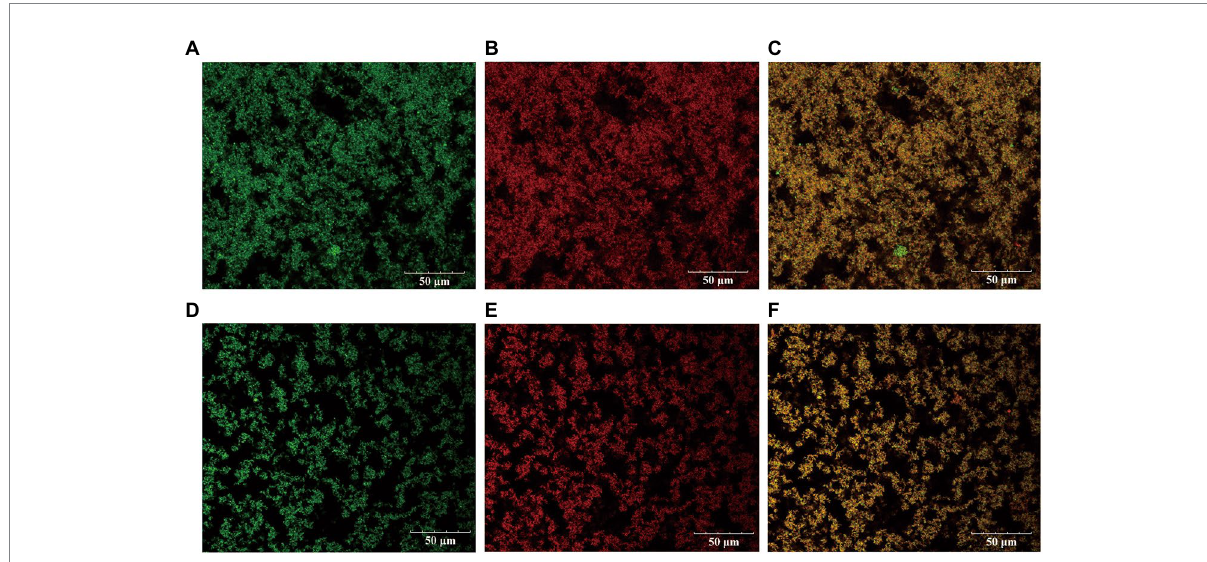
FIGURE 3 The distribution of protein and fat in L 1 fermented milk and kefir fermented milk under laser scanning confocal. ( A represents the fat distribution in L 1 , B represents the protein distribution in L 1 , and C is the superimposed effect of the two. D represents the fat distribution in kefir, E represents the protein distribution in kefir, and F is the superimposed effect of the